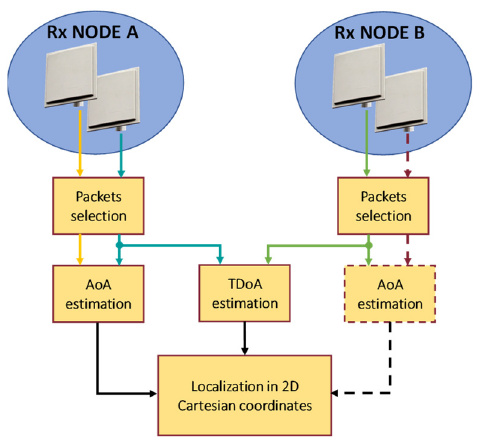
Figure 3. Processing scheme of the PSL exploiting a dual-node system.